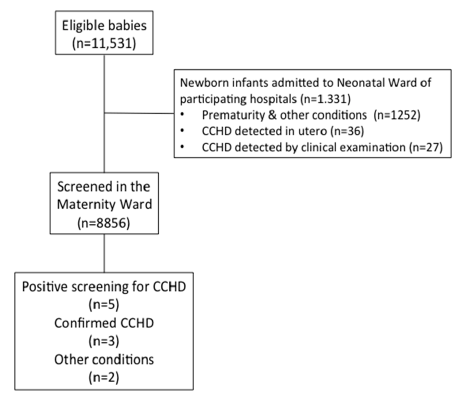
Figure 2. Consort diagram describing eligible patients, disregarded, and finally screened for critical congenital heart disease (CCHD) in the Pulsimat study. congenital heart disease (CCHD) in the Pulsimat study.